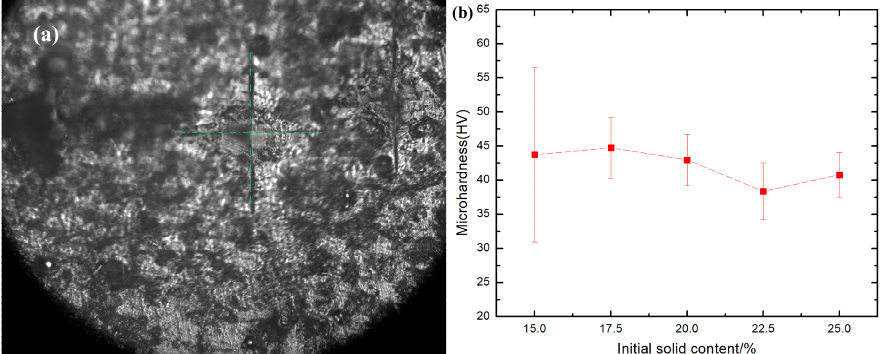
Figure 7. ( a ) Surface indentation of layered Al 2 O 3 /PMMA composites; ( b ) Microhardness of layered Al 2 O 3 /PMMA composites with different initial solid phase